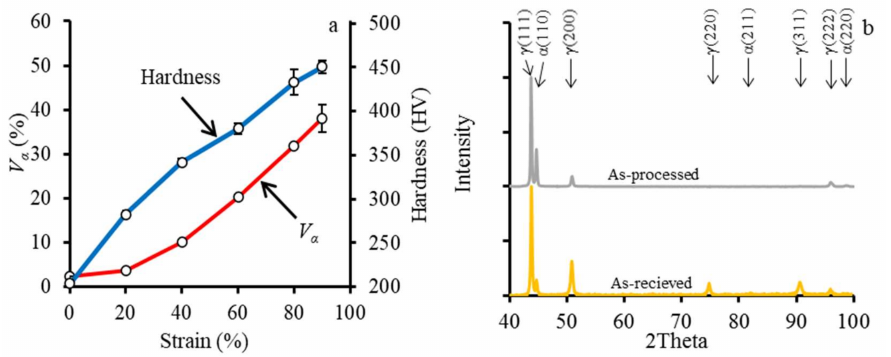
Figure 1. ( a ) Effect of cold strain on the α -phase content (V α ) and hardness and ( b ) XRD patterns of the as-received and as-processed program